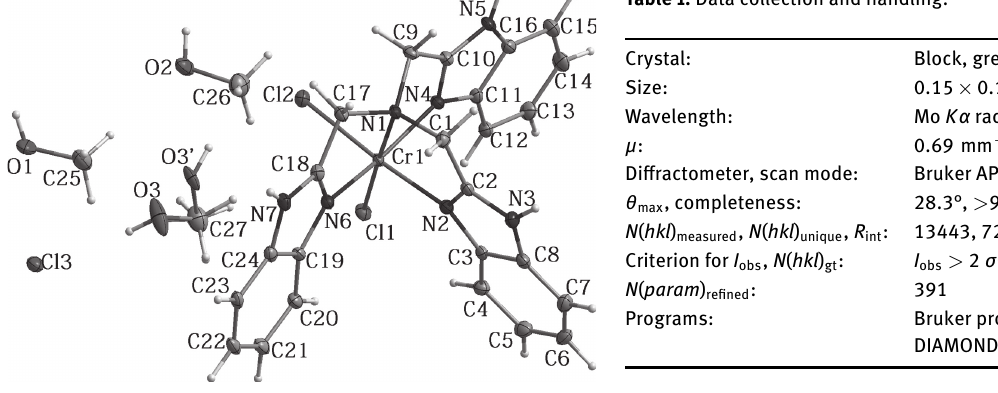
Table 1: Data collection and handling.